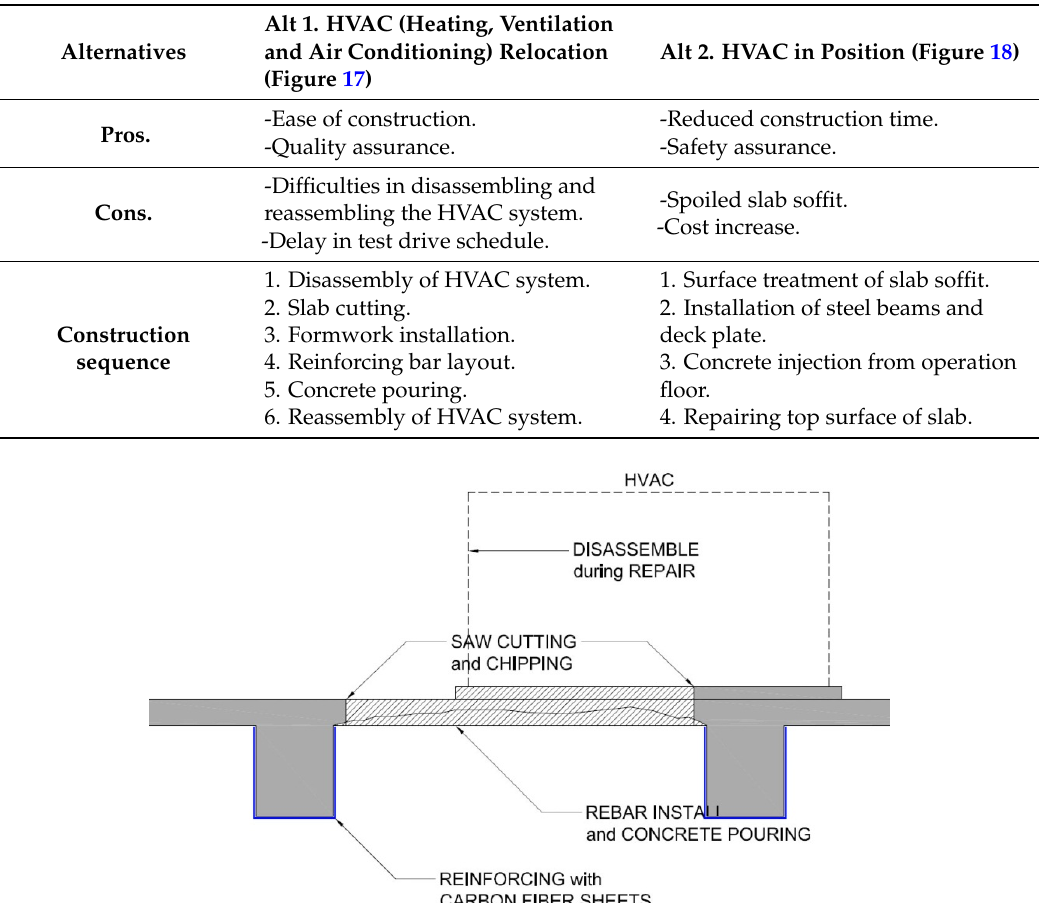
Table 4. Comparison of retrofit plans for the damaged slabs.